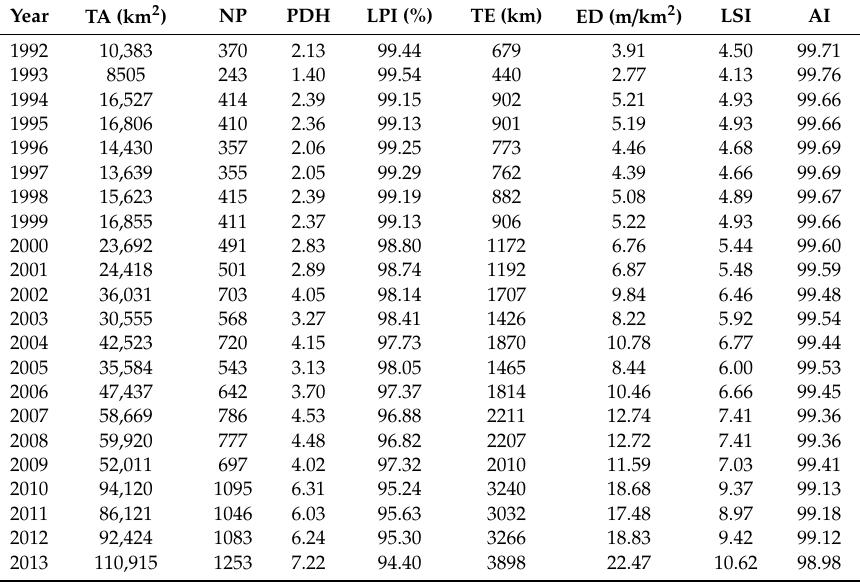
Table 2. Results on the landscape pattern indicators for the YREB from 1992 to